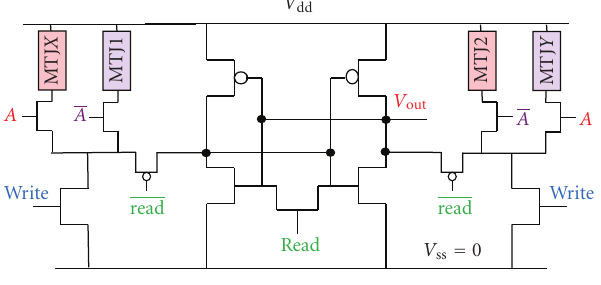
Figure 9: Multicontext TAS-MRAM cell.